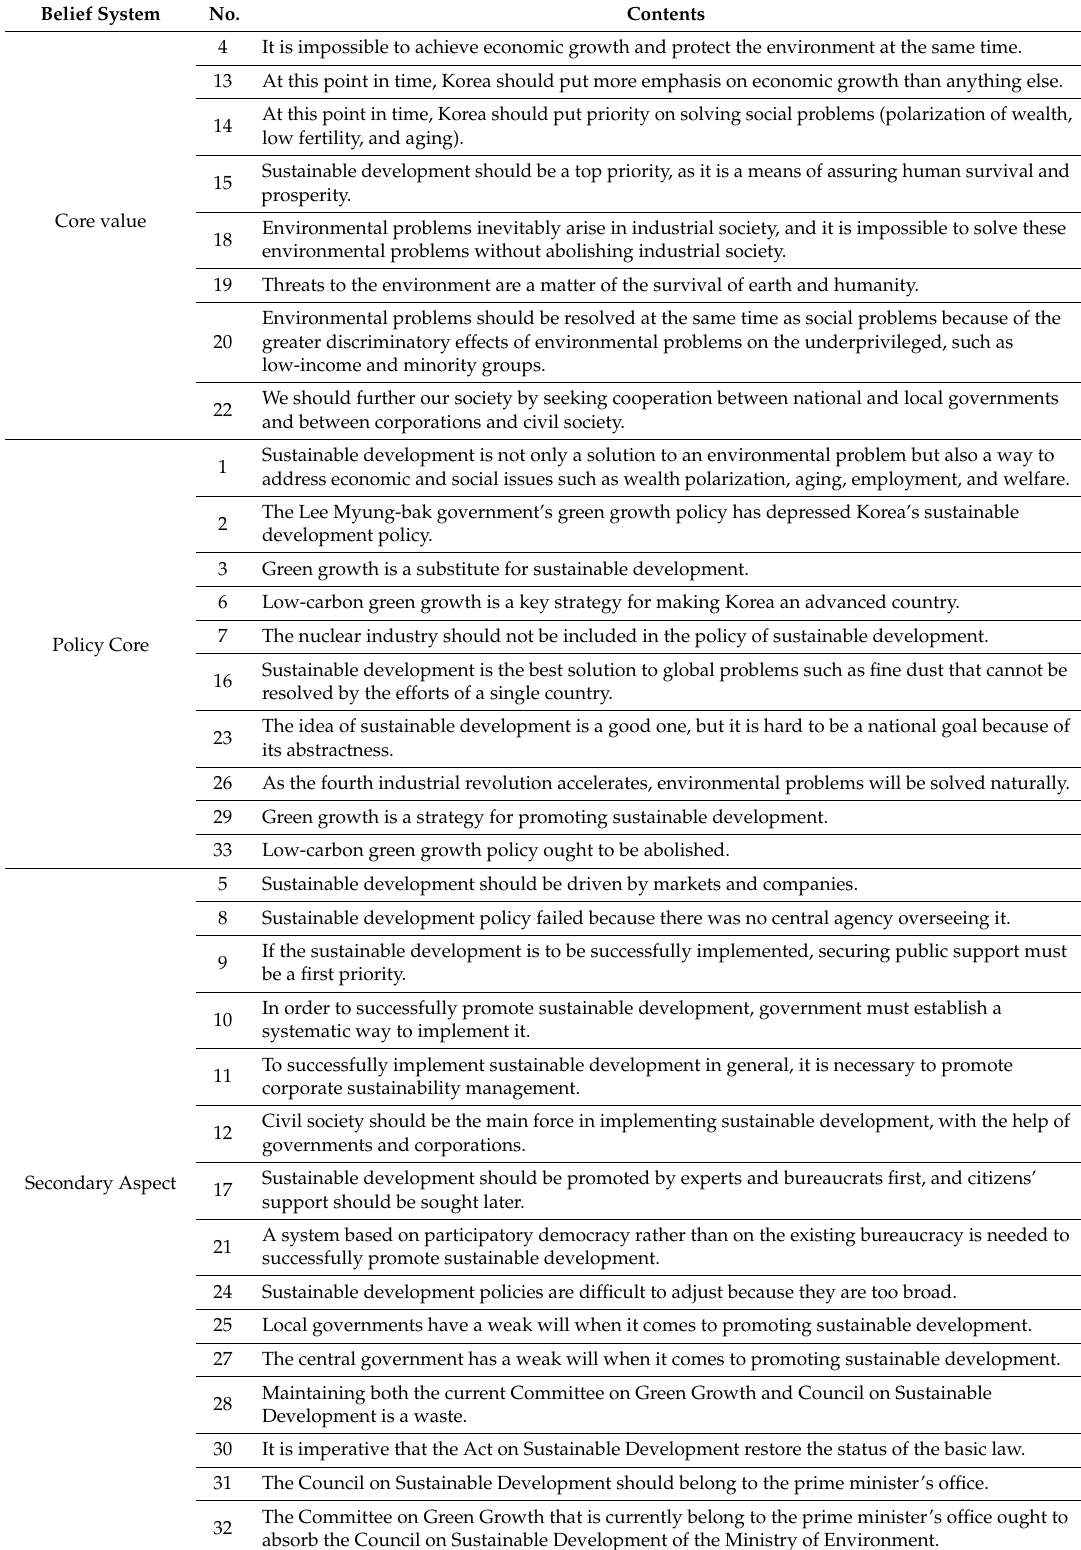
Table 2. Composition of Q